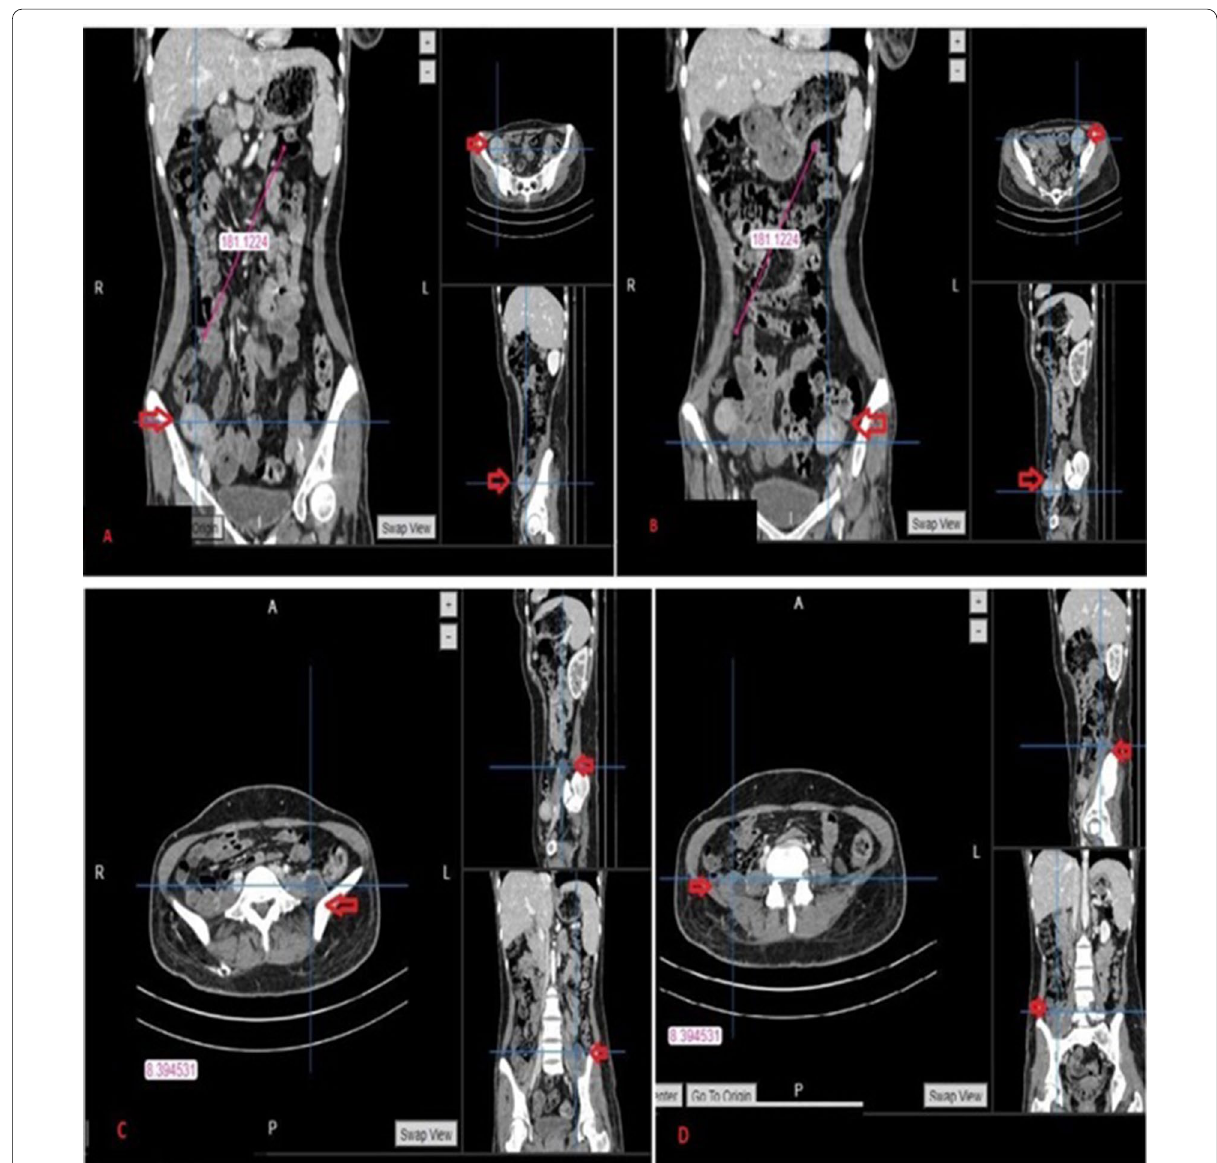
Fig. 3 CT scan with multi‑planar reconstruction a indicating the right corn of didelphis uterus. CT scan with multi‑planar reconstruction b indicating the left corn of didelphis uterus (all intended structures are indicated by arrow). CT scan with multi‑planar reconstruction c indicating the left ovary in abnormal position, also CT scan with multi‑planar reconstruction d indicating the right ovary in abnormal position (all intended structures is indicated by